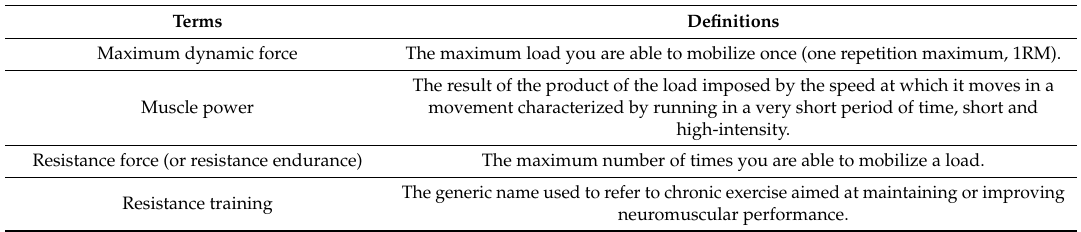
Table 1. Definitions of terms used in this review.